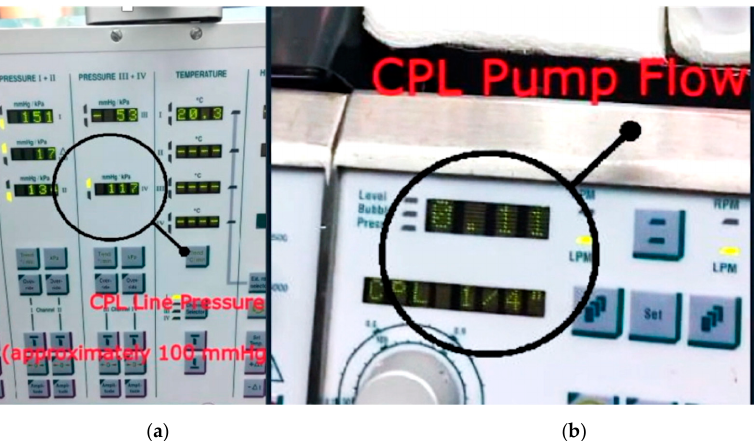
Figure 1. Examples of parameter estimates derived from cardiopulmonary bypass machine: ( a ) pres- sure drop on the cardioplegia line during selective administration in a venous graft; ( b ) amount of flow selectively delivered.